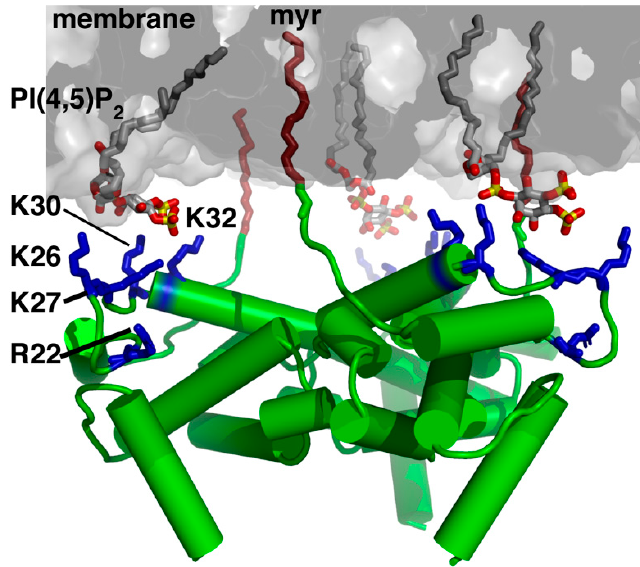
Figure 2. A model of the HIV ‐ 1 MA trimer bound to membrane. MA–membrane interaction is mediated by the myr group, basic residues (Arg 22 , Lys 26 , Lys 27 , Lys 30 and Lys 32 ) in the high basic region (HBR; blue), and the polar head of PI(4,5)P 2 . Membrane bilayer was generated in VMD membrane builder plug ‐ in [53]. PI(4,5)P 2 was generated in Avogadro [54]. The myr ‐ exposed MA trimer was constructed by superimposition with the x ‐ ray structure of myr(–)MA (PDB ID: 1HIW). Note that the N ‐ terminal Met, which is absent in the myristoylated protein, is designated as residue 1. In contrast, other studies considered the N ‐ terminal Gly of the myristoylated protein as residue 1.